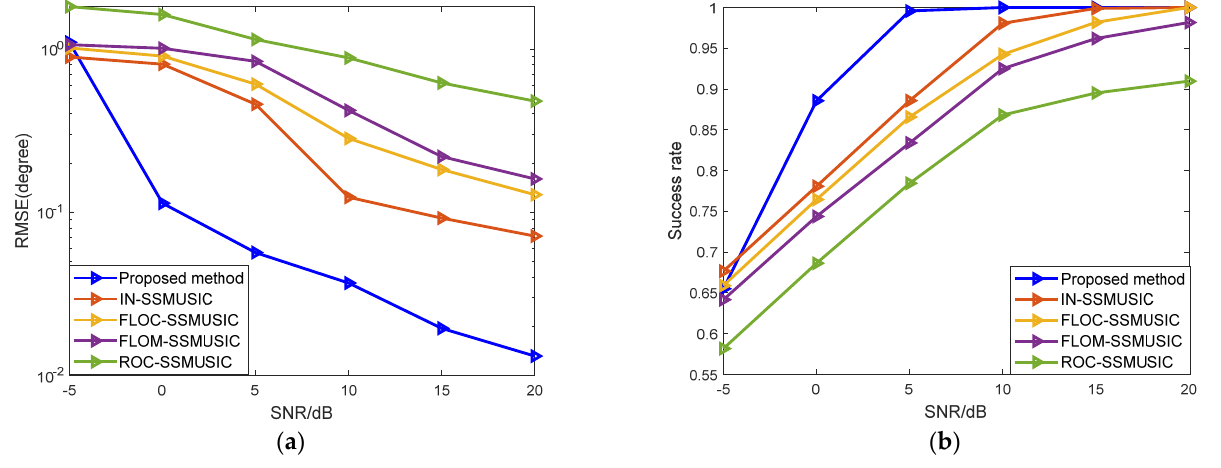
Figure 4. Analysis of mean square error and success rate under GMM noise: ( a ) Relationship between RMSE and SNR; ( b ) Relationship between success rate and SNR.